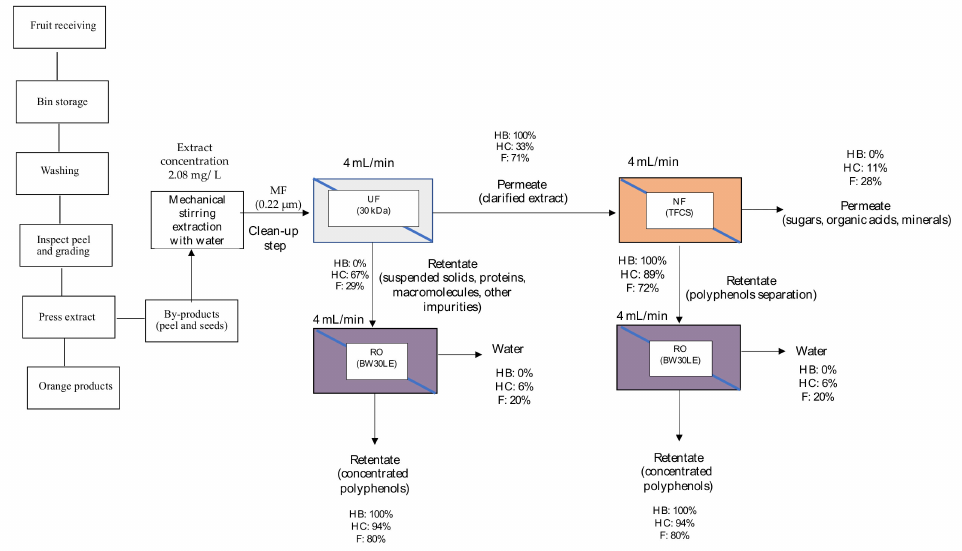
Figure 7. Scheme of the proposed integrated membrane process for the recovery of polyphenols from orange